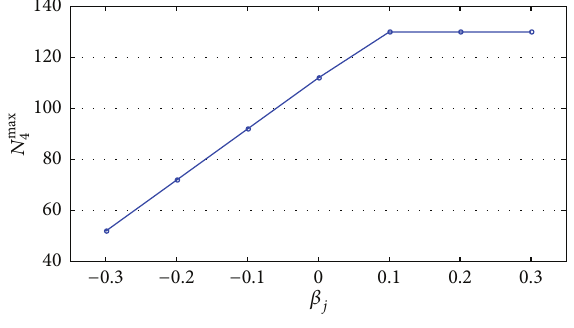
Figure 6: Curve of 𝑁 max 4 varied with 𝛽 𝑗 .